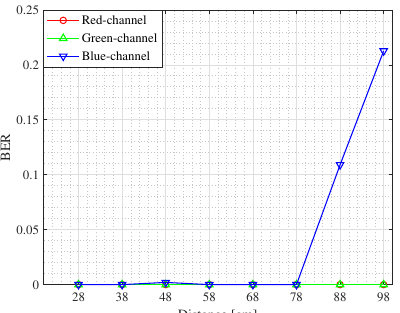
Figure 15. BER performance according to display-camera distance.